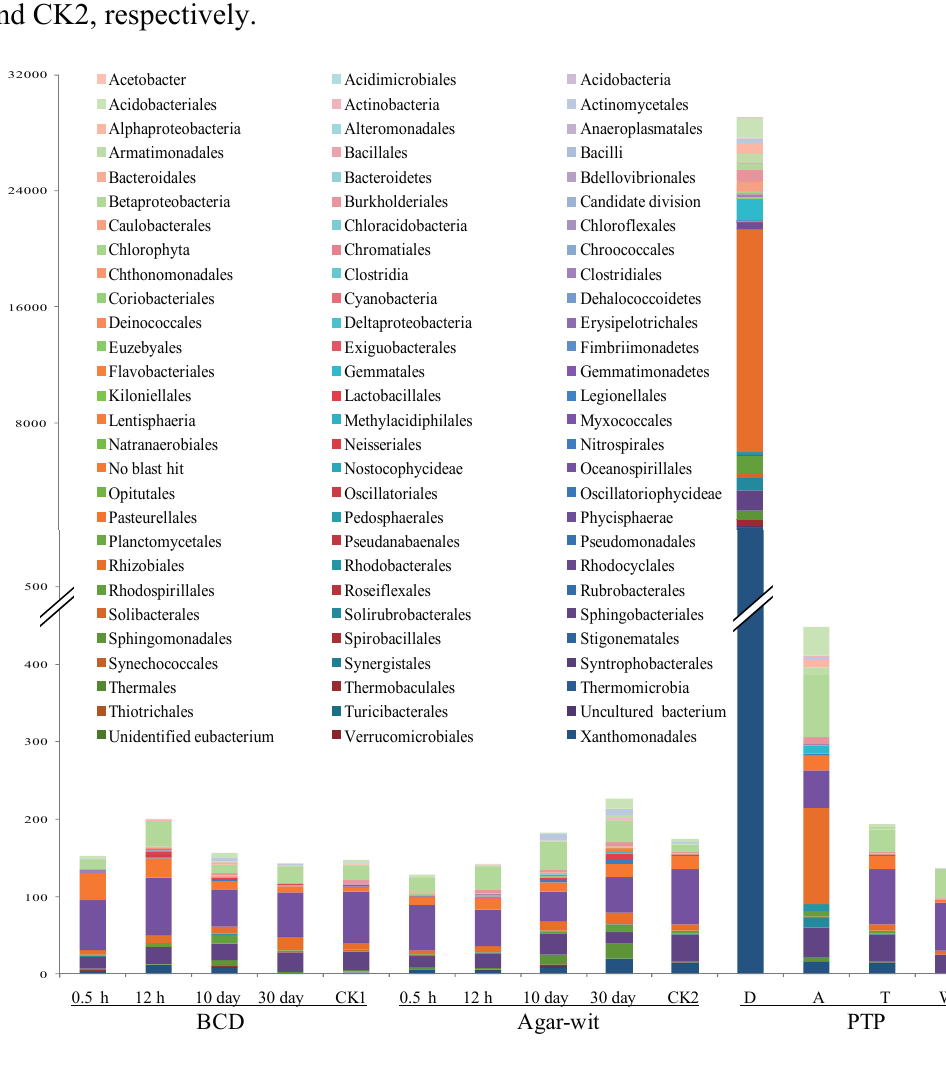
Figure 2. Distribution of bacterial OUTs at the ordinal level in the agarwood induced by three different wounding methods, BCD, Agar-Wit and PTP. The wounded wood obtained by the partial-trunk-pruning (PTP) method was divided into four zones, the decay (D), agarwood (A), transition (T), and white (W) zones. The samples obtained from the untreated healthy trees and the trees treated by the Agar-wit with ddH 2 O not inducer are referred to as CK1 and CK2,